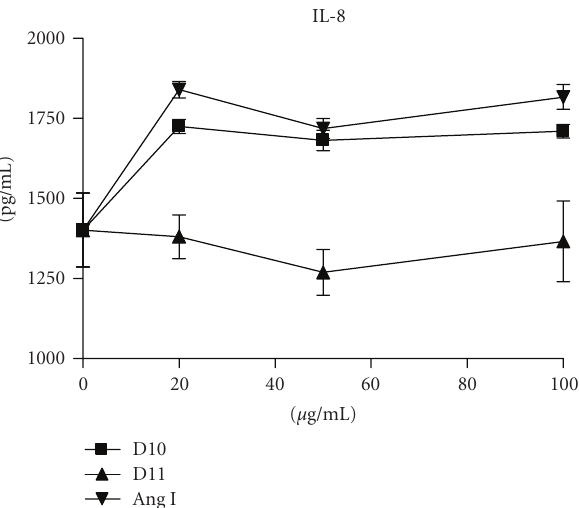
Figure 8: IL-8 production of A549 cells induced by D10 peptide and Ang I. A549 cells (1 × 10 5 ) were incubated with or without peptides for 48 hours. The levels of IL-8 in the culture supernatants were assayed as described in Section 2. Data represents the mean ± SD of